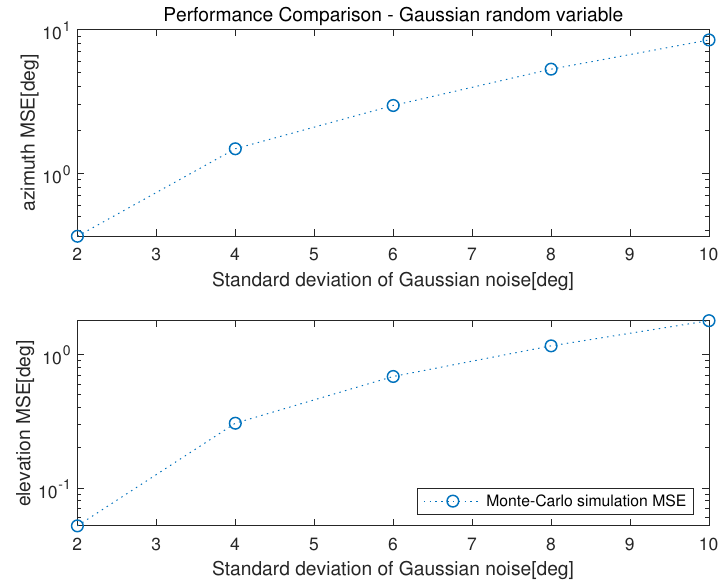
Figure 10. Performance for Gaussian − distributed phase measurement error with θ ( 0 ) = 120 ◦ and ψ ( 0 ) = 75 ◦ . This figure shows the MSEs of azimuth and elevation with respect to phase error at a signal with low incident elevation by monte-carlo simulation(rectangular planar